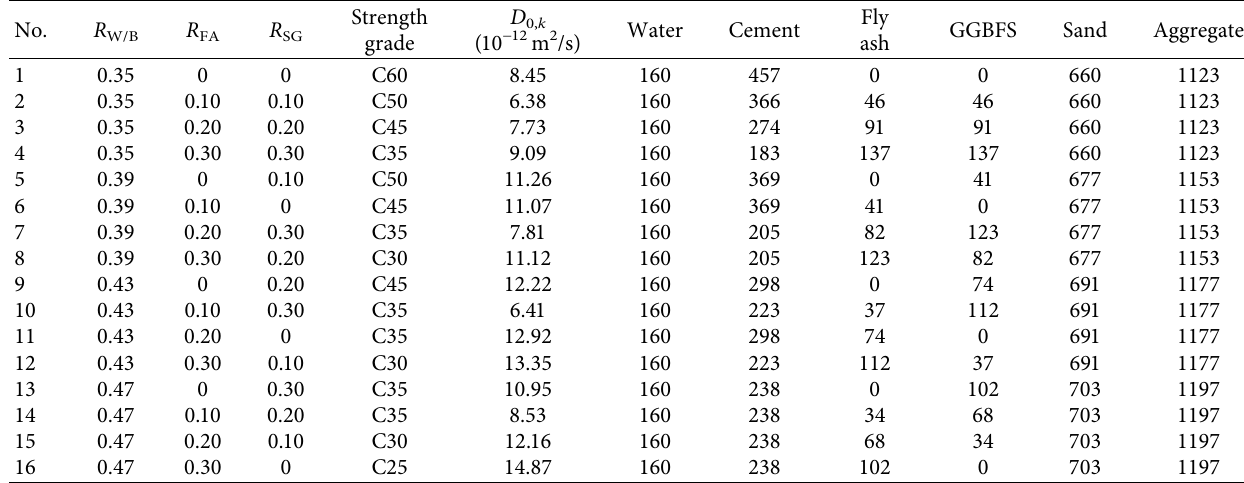
Table 10: Te contents of raw materials of concrete in 1m 3 concrete (kg/m 3